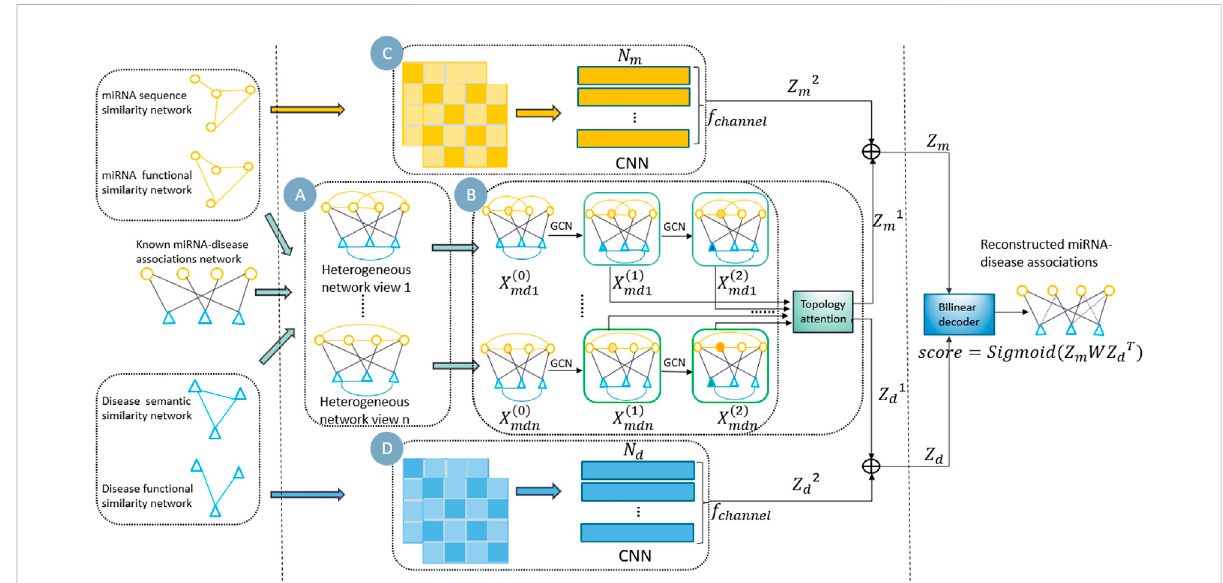
FIGURE 1 OverviewofMVIFMDA. (A) ConstructionofmultiplemiRNA-diseaseheterogeneousnetworksusingknownMDAsandthesimilaritiesofmiRNAs and diseases. (B) Encoding of heterogeneous network views by GCN to extract topology representations, and using topology representation level attention mechanism to adaptively fuse the different topology information. (C) and (D) Encoding of similarity views by CNN to obtain attribute representations of miRNAs and diseases,